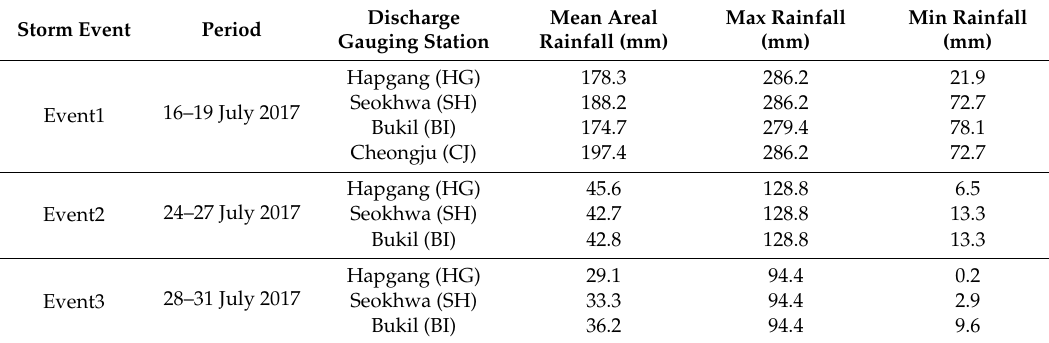
Table 2. Characteristics of rainfall